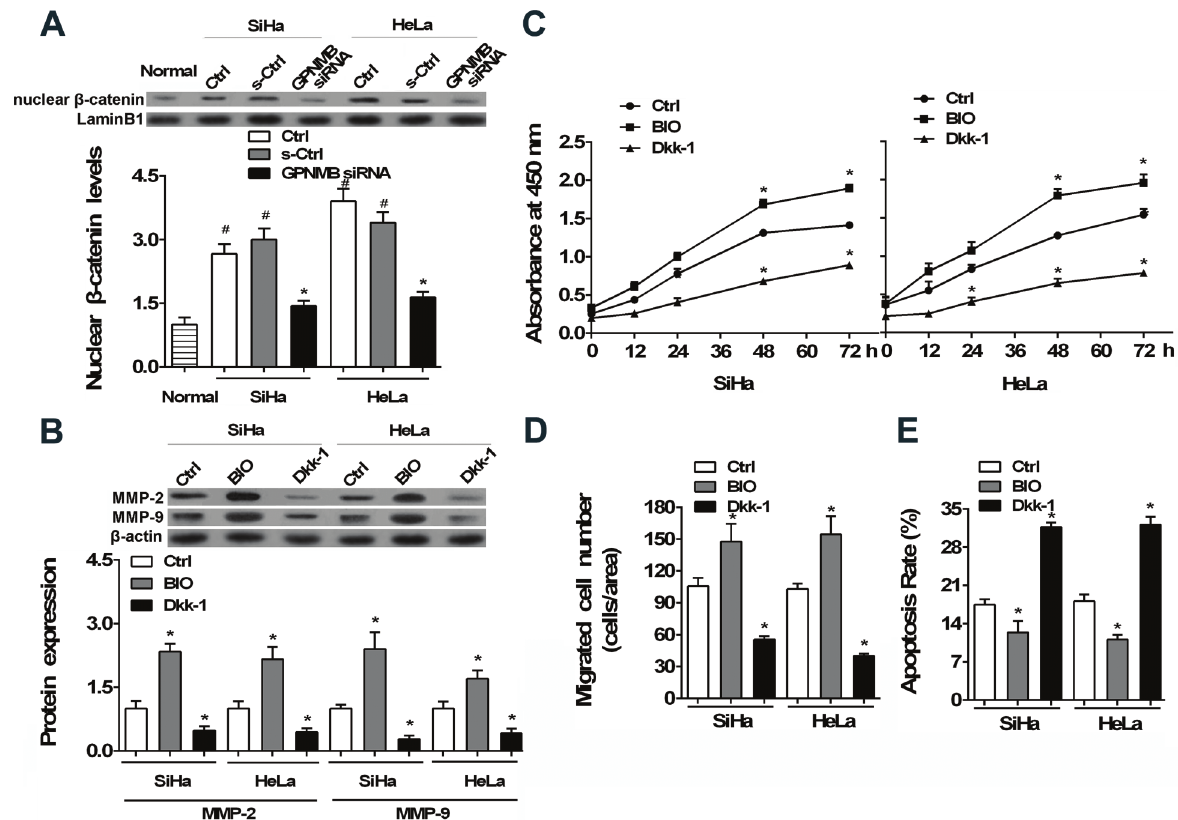
Figure 4. Association between Wnt/ b -catenin pathway and glycoprotein nonmetastatic melanoma protein B (GPNMB)-mediated cervical cancer tumorigenesis. SiHa and HeLa cells were cultured in normal medium (Ctrl), then transfected with GPNMB siRNA or negative control siRNA (s-Ctrl). A , Expression of nuclear b -catenin measured by western blotting in SiHa and HeLa cells as well as in normal cervical epithelial cells. B , Cells were treated by 100 ng/ml Dkk-1 or 1 nM BIO for 48 h or not, and matrix metalloproteinases (MMP)-2 and MMP-9 expressions were then measured by western blotting. C , CCK-8 assay was conducted to clarify the proliferation of SiHa and HeLa cells after treatment with Dkk-1 or BIO. D , Migration capacity of cells tested by Transwell Boyden chambers. E , Apoptosis of cells measured by fl ow cytometric analysis. Data are reported as means ± SE. # P o 0.05 vs Normal; *P o 0.05 vs Ctrl